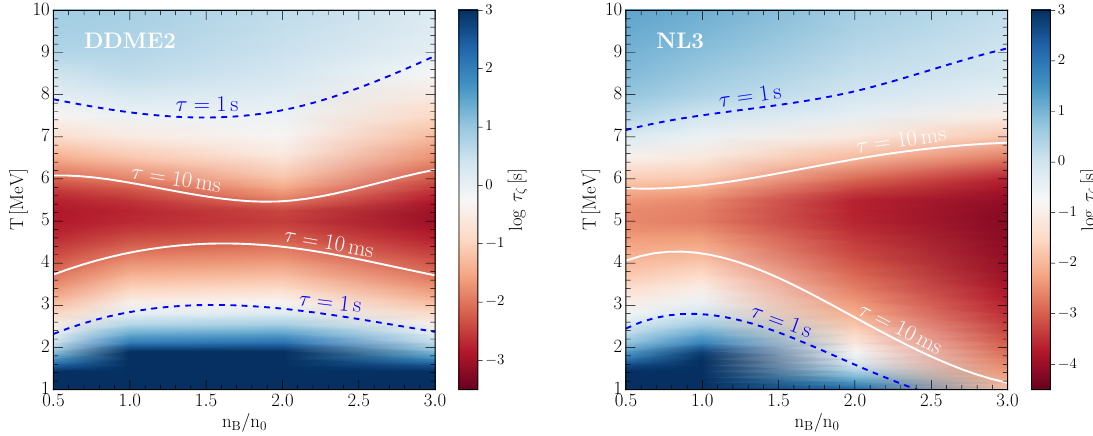
Figure 11. Same as Figure 10 but for frequency f = 10